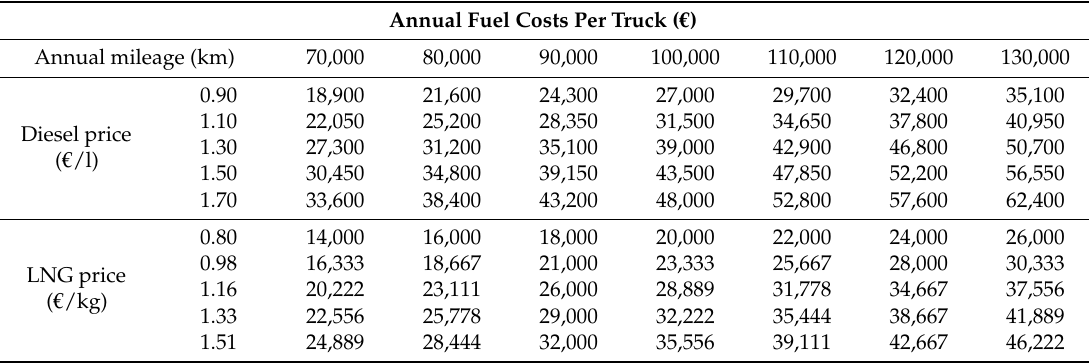
Table 6. Annual fuel costs for diesel and LNG